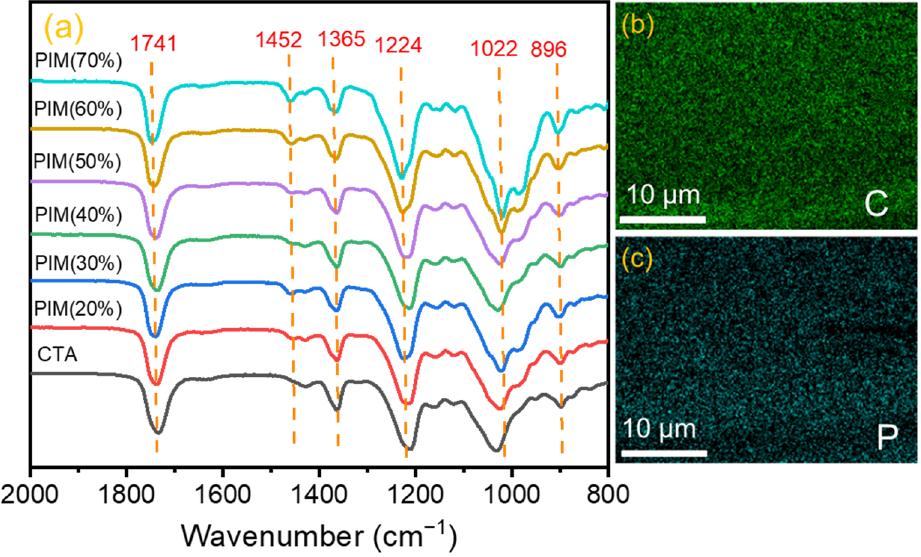
Figure 5. ( a ) FTIR spectra of CTA and the obtained PIMs; ( b , c ) element mapping of CTA/P507-TBP 60% membrane.